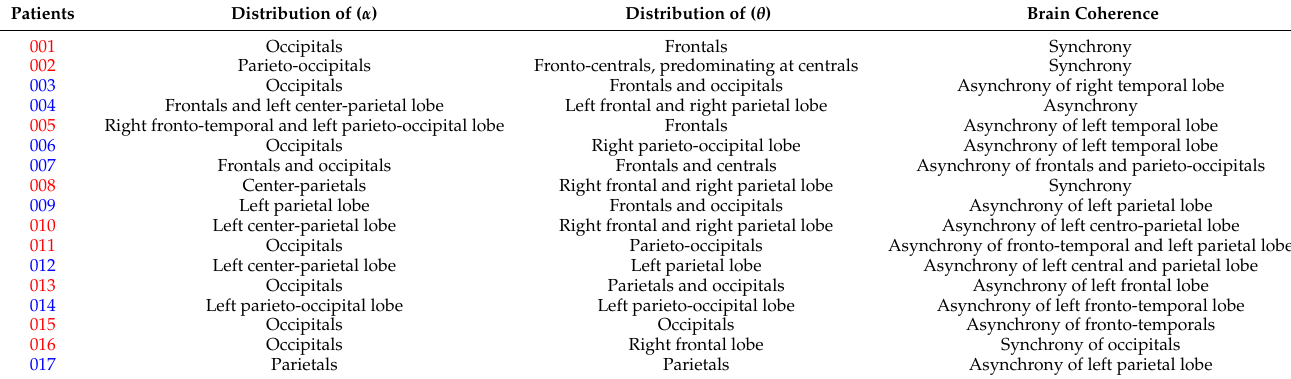
Red represents patients who used filters transmitting long-wavelength light (red-orange-yellow) and blue the patients who used filters transmitting low-wavelength light (from bright to dark blue and the combination of grey-blue and violet-blue). Filters transmitting medium-wavelength light (green) are stabilizing filters and were combined either with red or blue filters according to the needs of each patient. EEG recordings were carried-out in the waking-state. ( α ), alpha-wave; ( θ ), theta-wave. Table 15. Distribution of alpha and theta-waves and the state of brain coherence after LTH of SA group. Patients